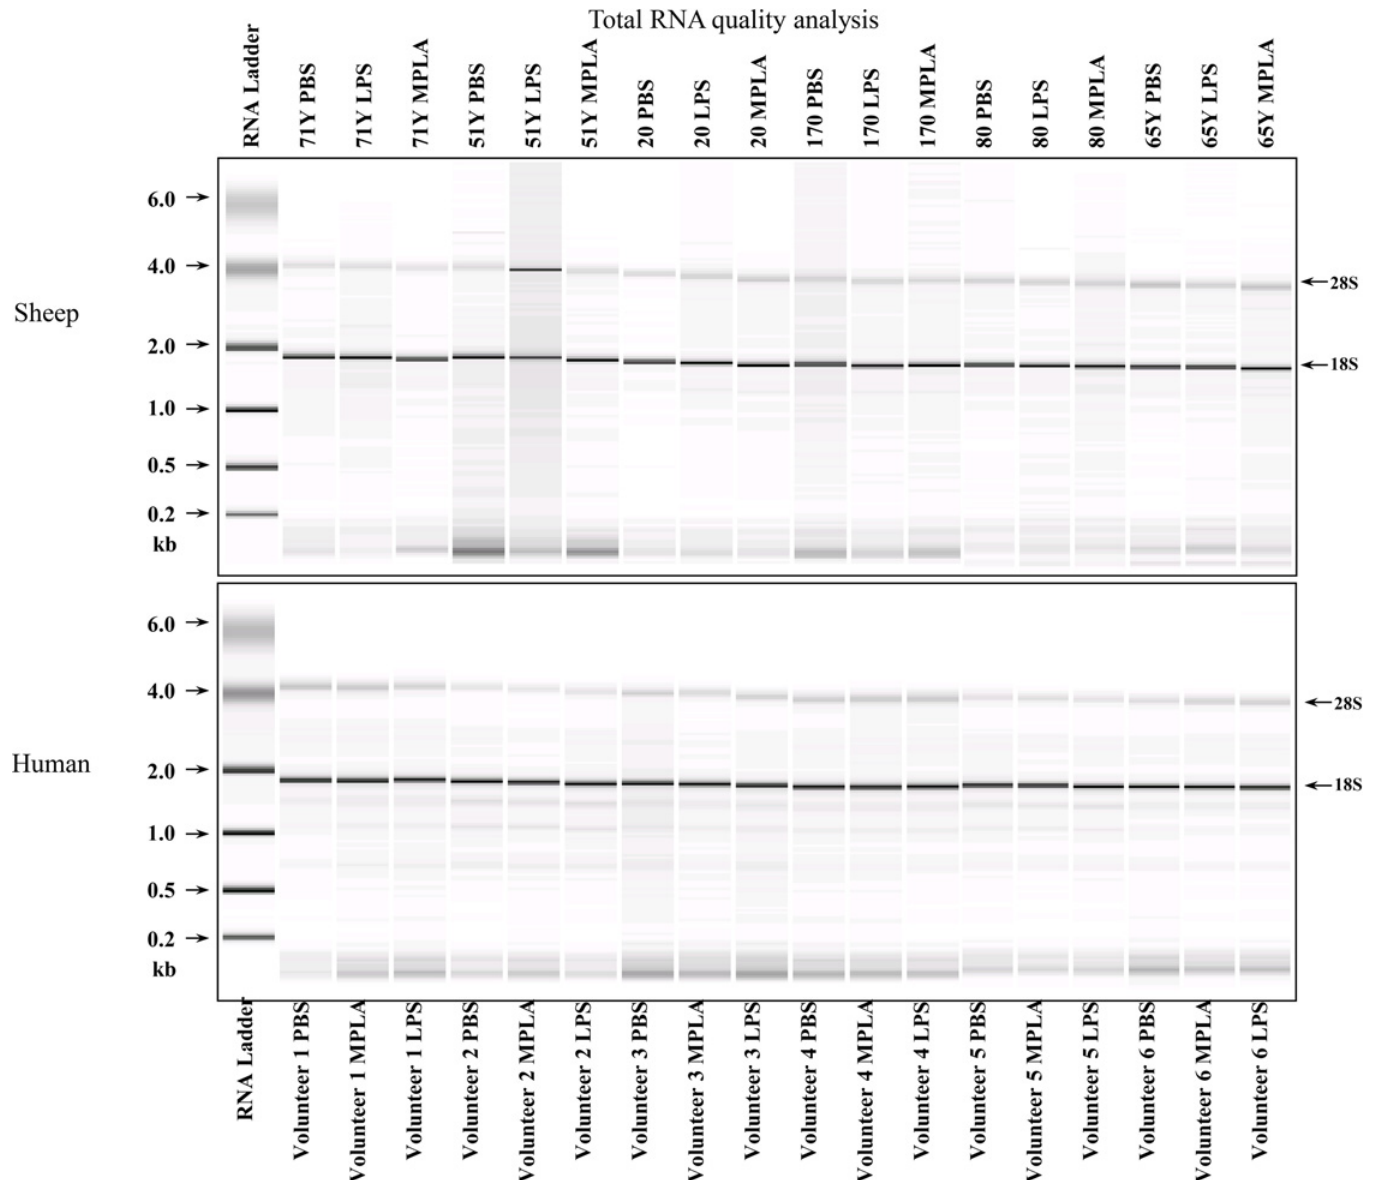
Fig 1. Total RNA quality analysis. Quality of the purified RNA was assessed by visualization of 18S and 28S RNA bands using an Agilent BioAnalyzer 2100 (Agilent Technologies, CA). Resulting electroperograms were used in the calculation of the 28S/18S